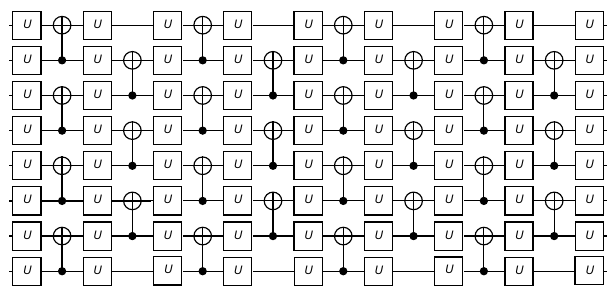
FIG. 15. Eight-qubit wide and eight-layer deep circuit layout. Gates U represent single-qubit unitary gates, and the two-qubit gates are controlled- NOT gates. For circuits in T , gates U are all Clifford. The initial state is | 0 (cid:2) ⊗ n , and the measurement is done in the Z basis on the bottom